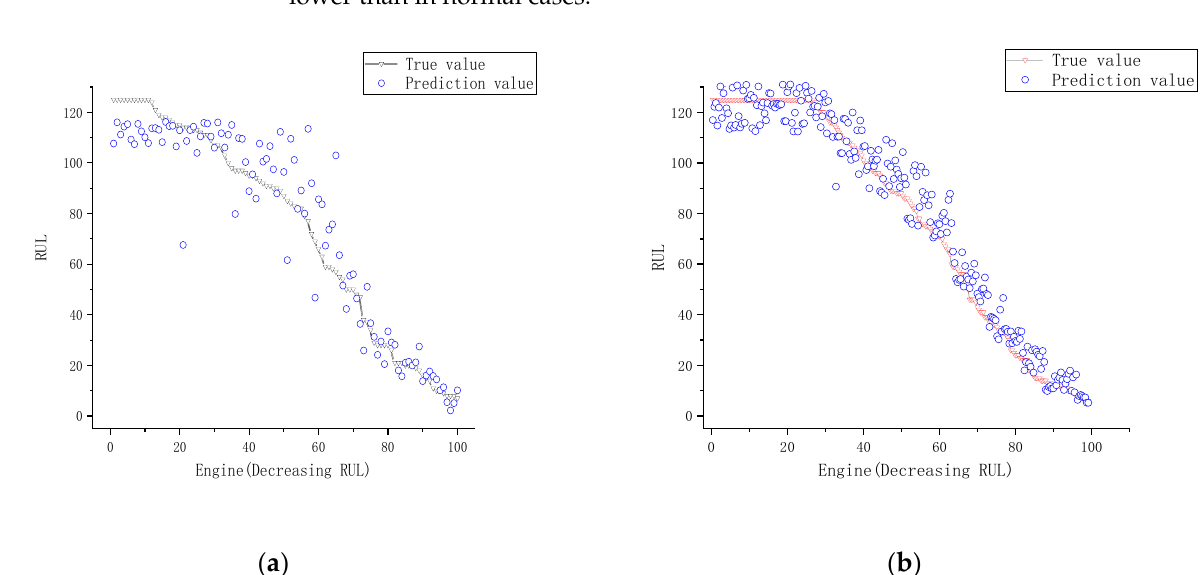
Figure 17. Comparison of results predicted by FGRNET and AM-FGRNET for the FD001. ( a , b ) Predicted results of FGRNET and AM-FGRNET, respectively. Table 12. Model performance comparison for RUL